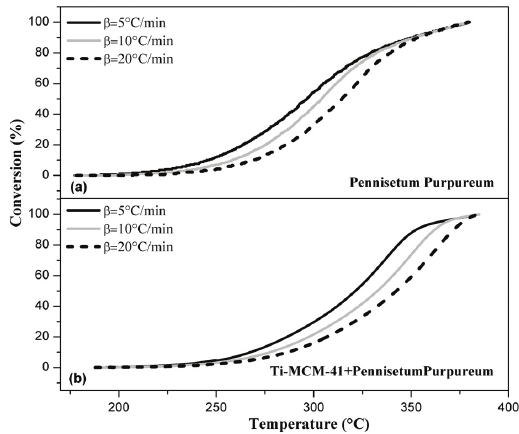
Figure 5. Conversion and pyrolysis curves of Pennisetum purpureum + Ti-MCM-41 (a) and pure Pennisetum purpureum (b).